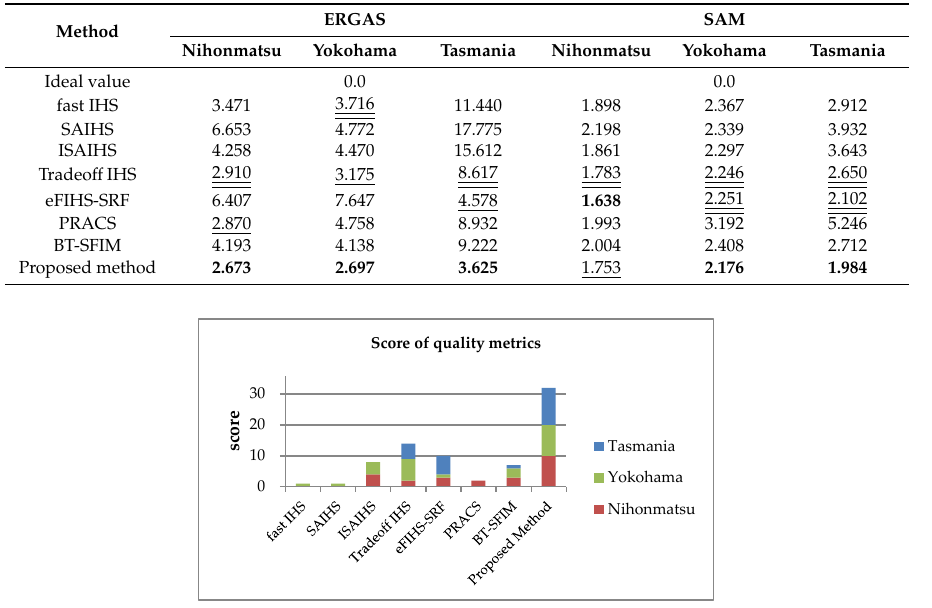
Figure 3. Quality metric result rank in three tested datasets: the score of the quality metrics is expressed as a cumulative bar chart.